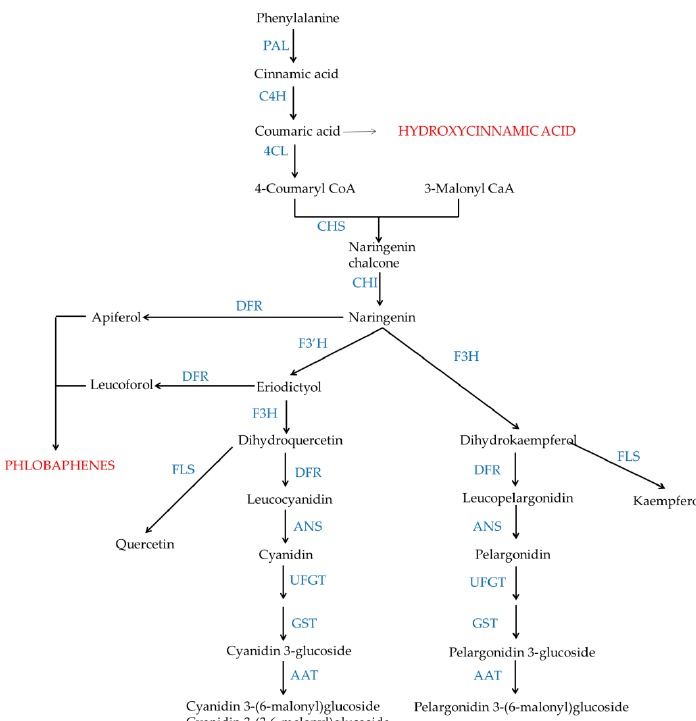
Figure 2. The biosynthesis pathways of anthocyanins in corn. AAT, anthocyanin acyltransferase; ANS, anthocyanidin synthase; 4CL, 4-coumaroyl; C4H, cinnamate 4-hydroxylase; CHS, chalcone synthase; CHI, chalcone isomerase; DFR, dihydroflavonol 4-reductase; F3H, flavanone 3-hydrox- ylase; F3′H, flavonoid 3′ -hydroxylase; FLS, flavonol synthase; GST, glutathione S-transferase; PAL, phenylalanine ammonia lyase; UFGT, flavonoid 3- O -glucosyltransferase. The extracts of purple corn contain six major anthocyanin compounds such as cyanidin- 3- O - β -D-glucoside, pelargonidin-3- O - β -D-glucoside, peonidin-3- O - β -D-glucoside, cyanidin- 3- O - β -D-(6-malonyl-glucoside), pelargonidin-3- O - β -D-(6-malonyl-glucoside), and peonidin- 3- O - β -D-(6-malonyl-glucoside). Among them, cyanidin 3- O - β -D-glucoside is the